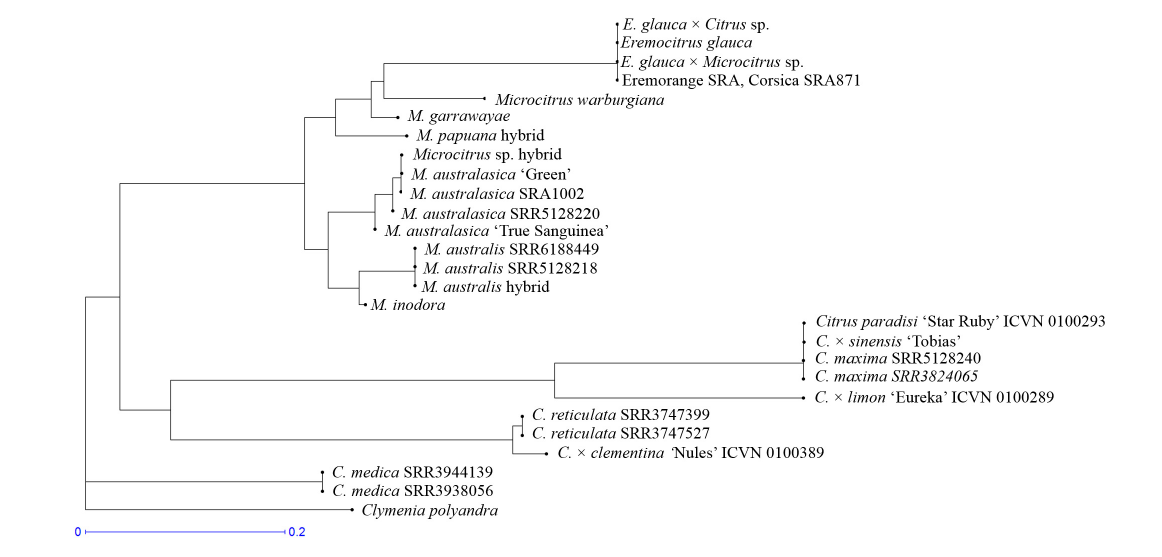
FIGURE8 Assignation of the mitochondrial genome of hybrids and admixed Oceanian accessions in relation to ancestral mitochondrial ones; NJ tree based on the genotyping for 40 mitochondrial diallelic DSNPs.